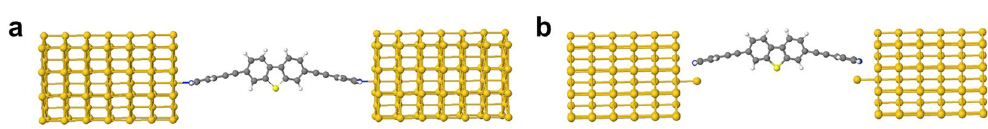
Figure 7. Geometry of the molecular junction containing a 1-S wire ( a ) on flat electrodes ( b ) on electrodes containing